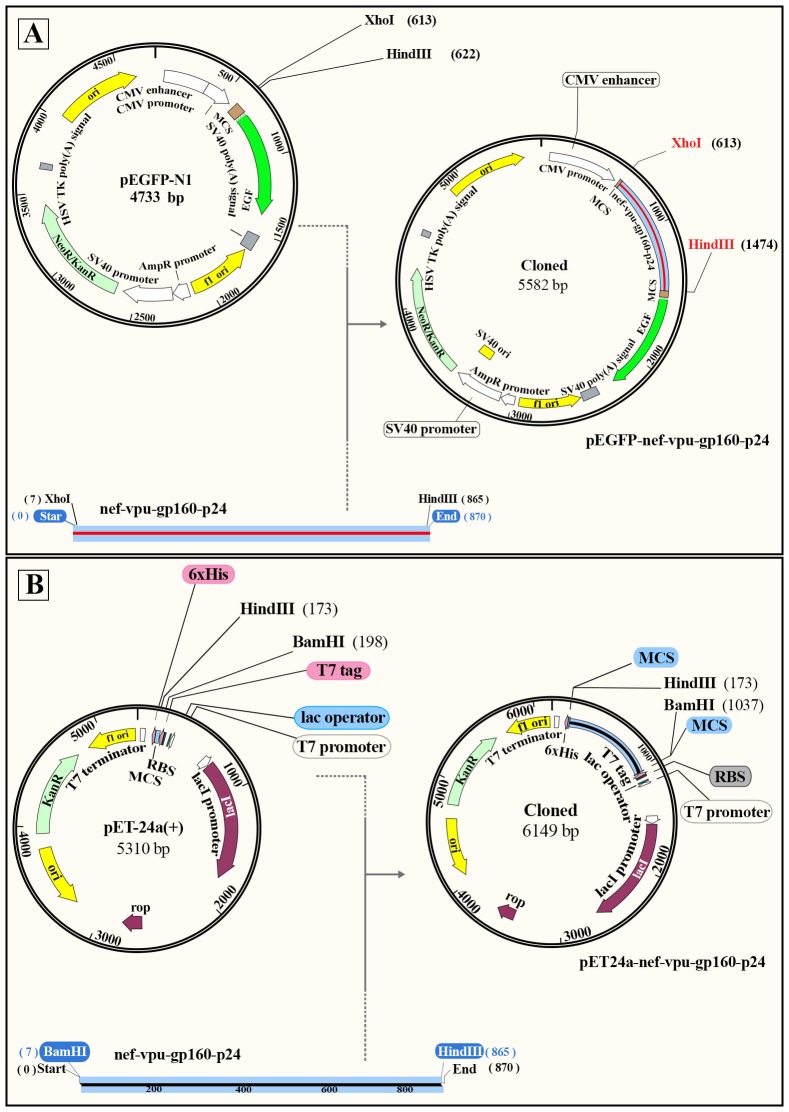
The schematic process of cloning.A) The nef-vpu-gp160-p24 fragment was digested from pUC57 with XhoI and HindIII, and then was ligated into pEGFP-N1 vector; B) The nef-vpu-gp160-p24 fragment was digested from pUC57 with BamHI and HindIII and then ligated into pET24a (+) vector.